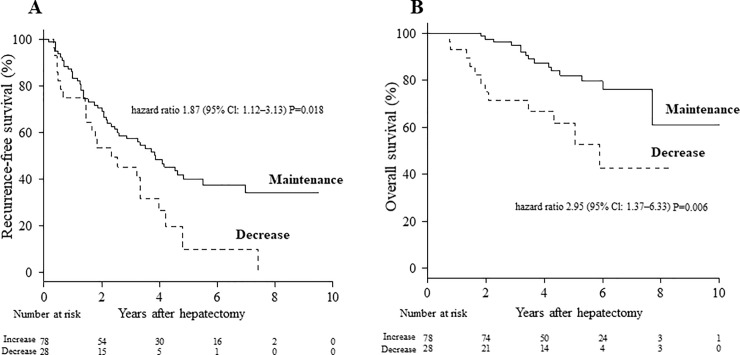
Survival outcomes between the maintenance and decrease groups.A, Recurrence-free survival. B, Overall survival. CI: confidence interval.